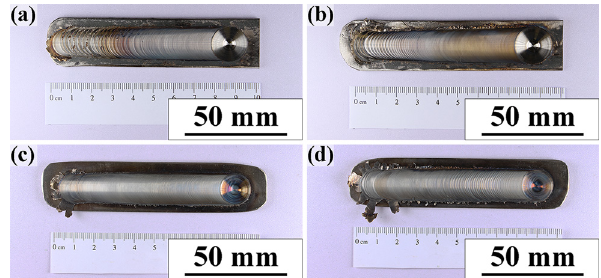
Figure 1: Appearances of the bead - on - plate welds at rotational speeds of ( a ) 200, ( b ) 300, ( c ) 400, and ( d ) 500